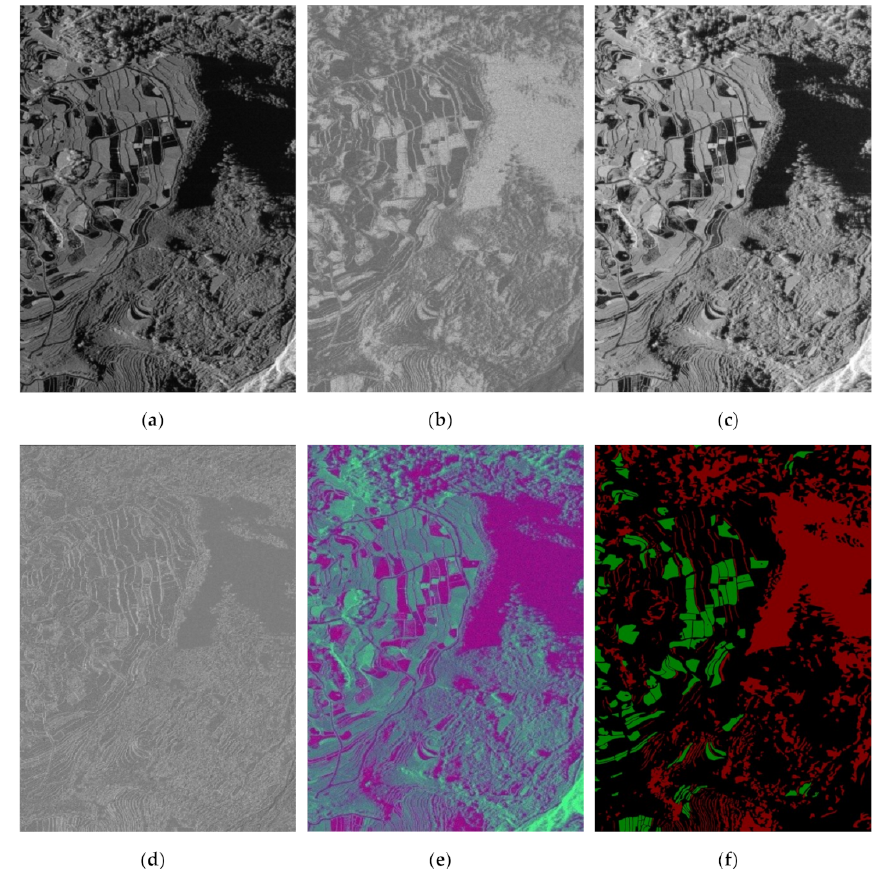
Figure 10. The SAR image, features and ground truth. ( a ) SAR image. ( b ) Large gradient dominant feature. ( c ) The grayscale mean feature. ( d ) The correlation feature. ( e ) The fusion feature of ( a ), ( b ) and ( c ). ( f ) The ground truth, the red color, green color, and black color denote shadow, water, and background